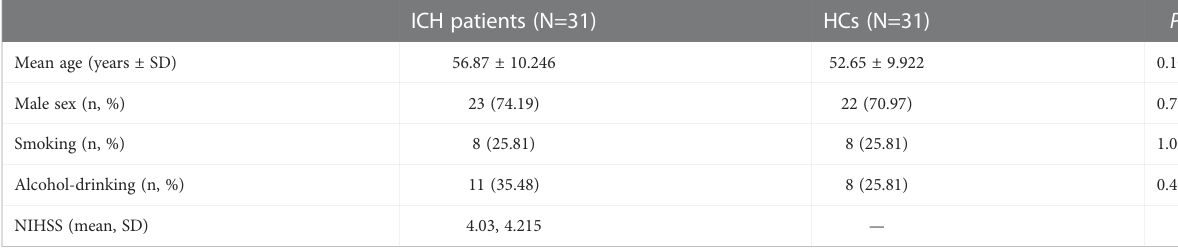
TABLE 1 Characteristics of the characteristics of the study